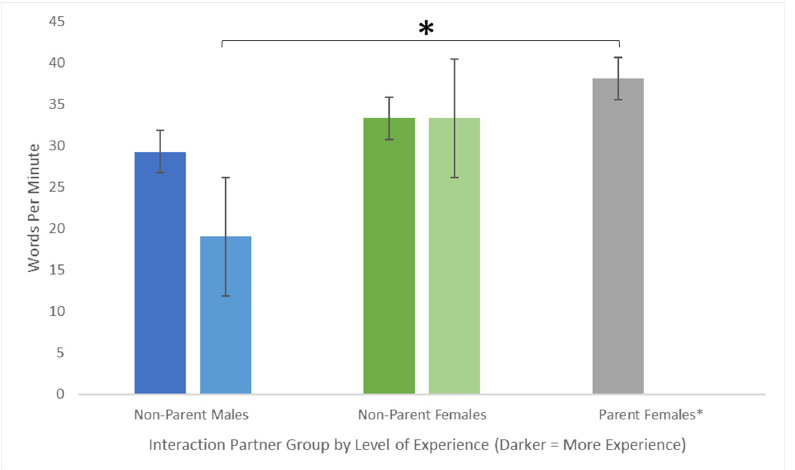
Figure 1. Differences in words produced per minute between interaction partner groups. Overall, words per minute differ between female parents and non-parent males only when accounting for experience with children. Note: * No Parent Females endorsed Low Experience with children.